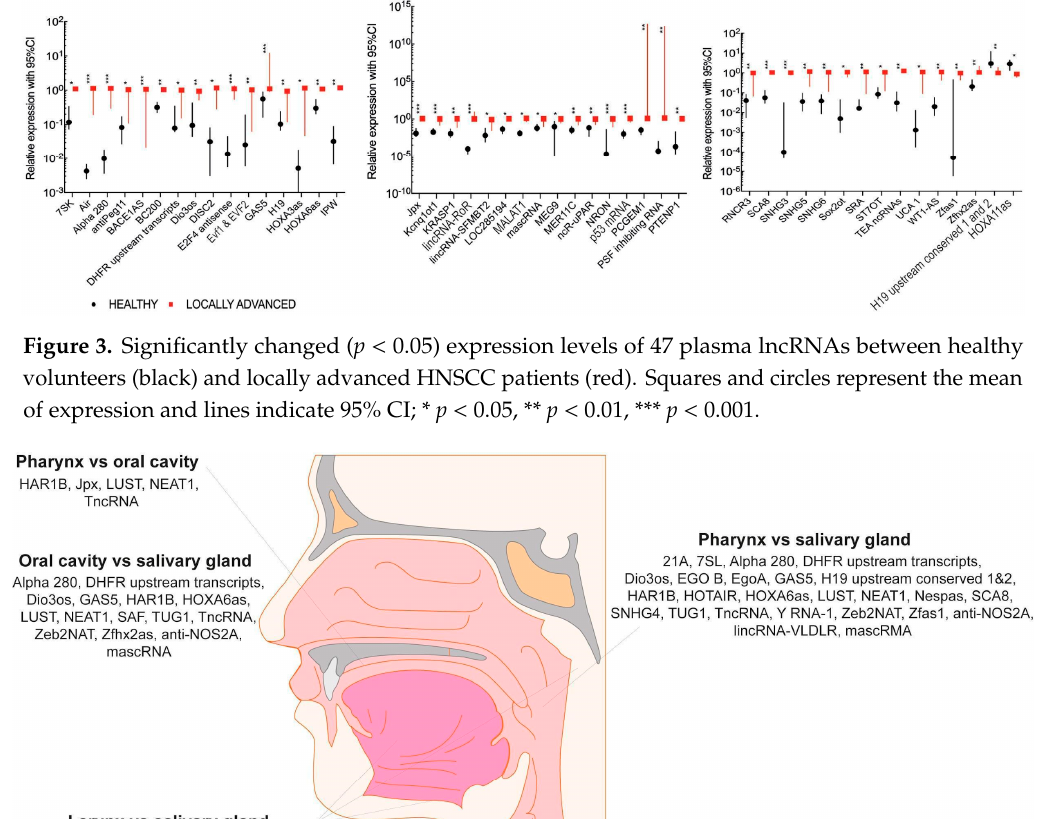
Figure 4. Changes in plasma lncRNA expression in HNSCC patients depending on the tumor localization in the pharynx, oral cavity, larynx and salivary gland sites. Only statistically significant changes ( p < 0.05) in lncRNAs between groups are presented.